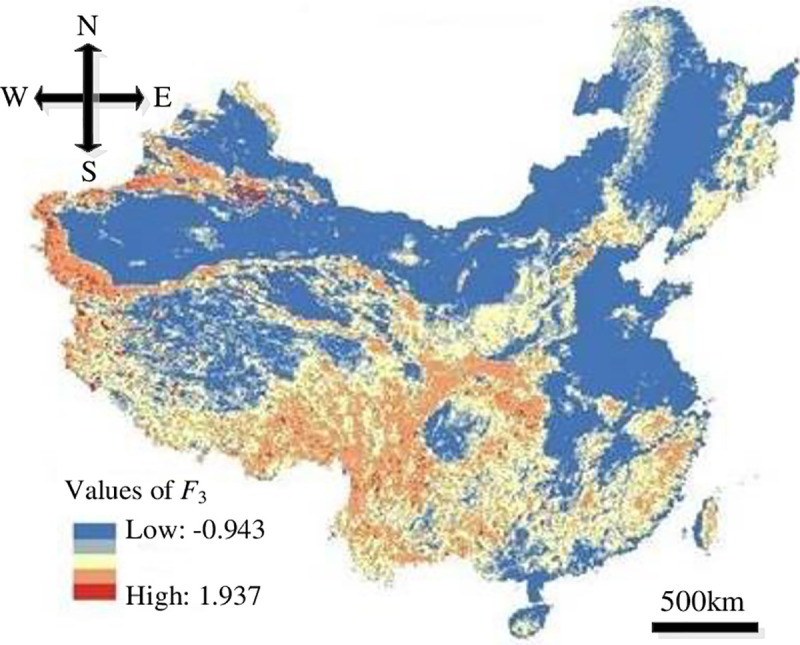
Distribution of F3.